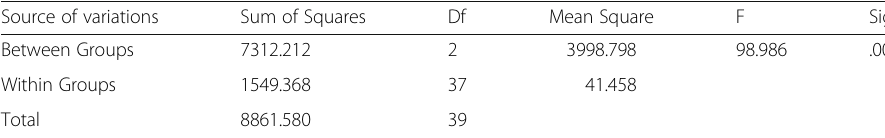
Table 6 Significance of Listening Test Achievement and FLLA Level Source of